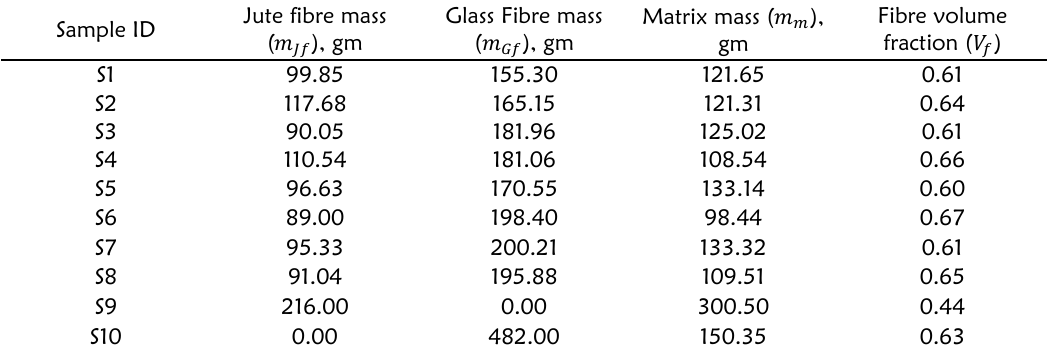
Table 1: Fibre volume fractions of the fabricated composite